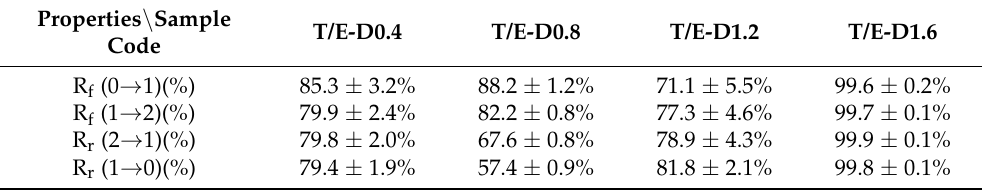
Table 3. Triple shape memory performance of the TPI/EVA composites.